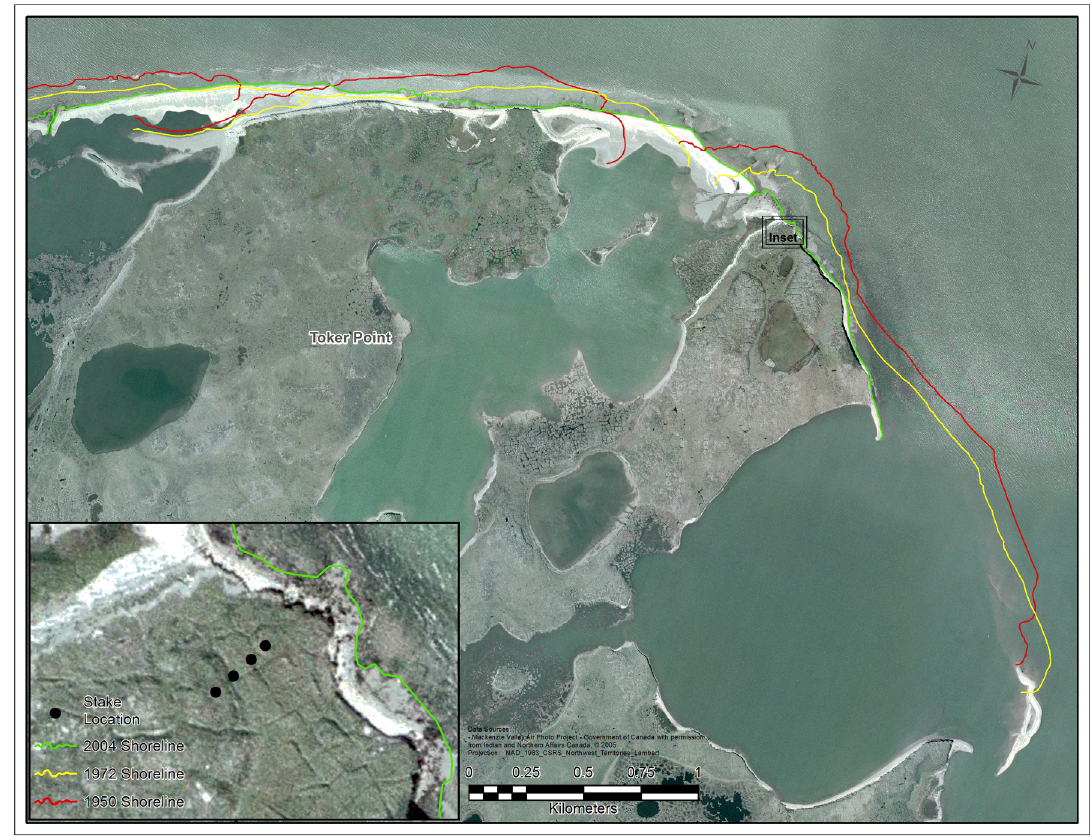
Fig. 5: Toker Point shoreline positions (inset: monitoring stake locations).